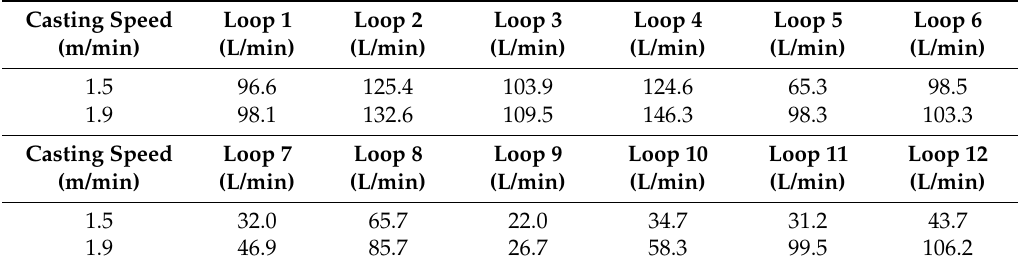
Table 3. Optimal cooling intensities for cooling loops and different casting speeds.